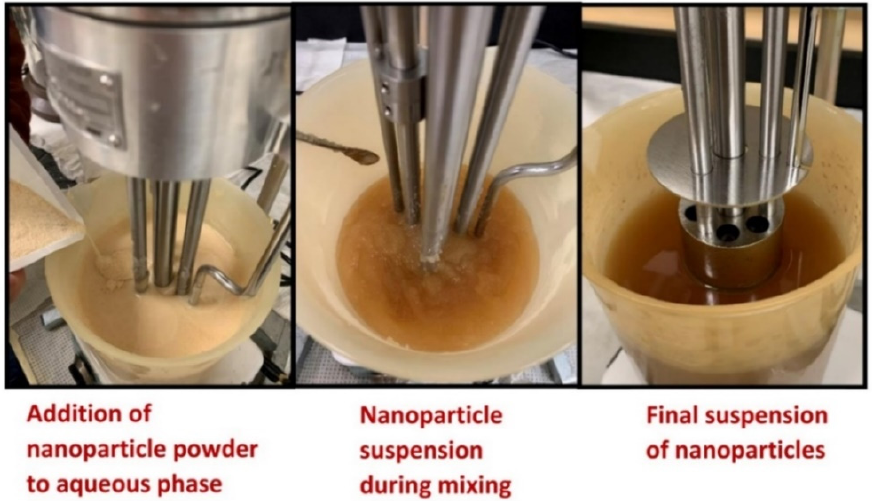
Figure 3. Preparation of suspension of starch nanoparticles.